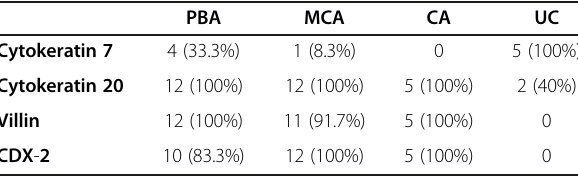
Table 5 Results of Cytokeratin 7 & 20, villin and CDX-2 immunostaining of primary bladder adenocarcinoma, metastatic and primary colorectal adenocarcinoma and urothelial